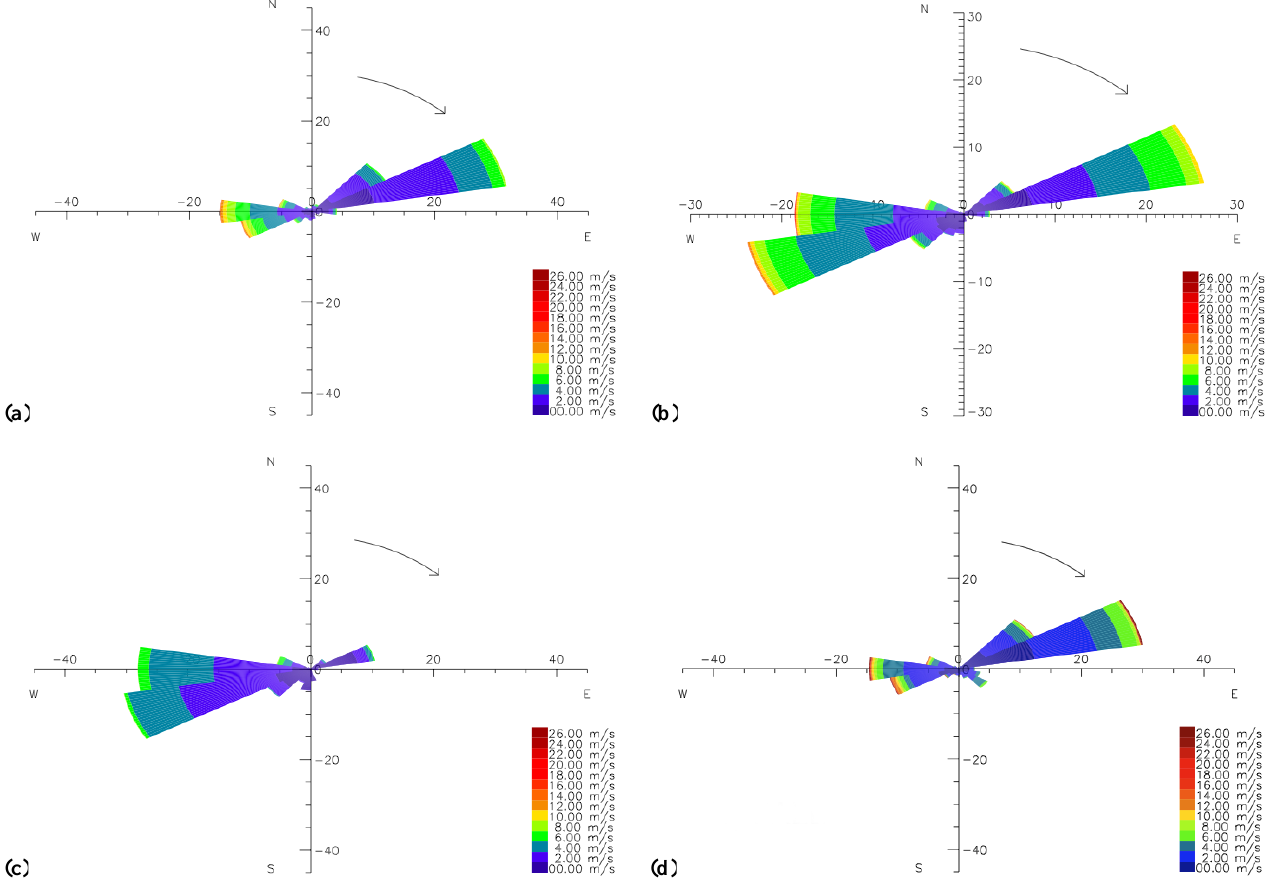
Figure 4. Wind rose recorded at the surface station for the period 2007–2008 for (a) winter, (b) spring, (c) summer, and (d) fall. As in Fig. 2a. Colour scale shows the wind intensity (ms − 1